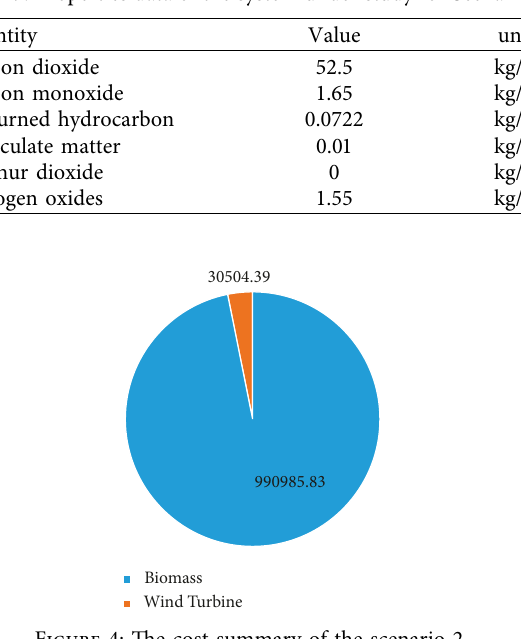
Figure 3: Monthly electric production in different months of the year (Scenario 2). Table 6: The amount of energy fraction extracted in different ways.